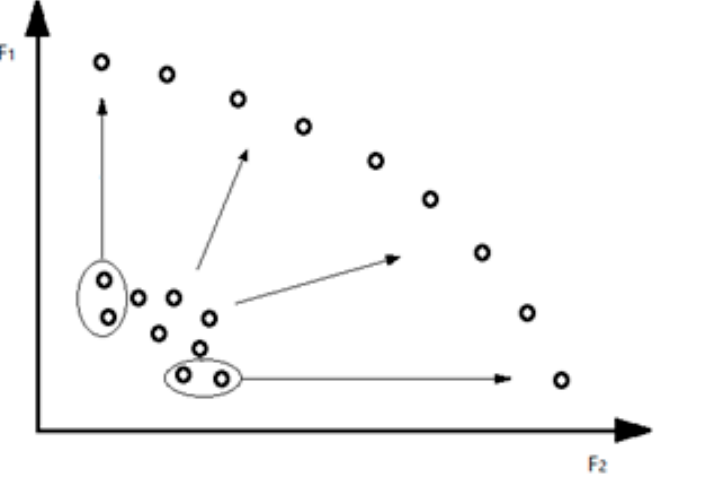
Figure 5. Single entry external archive.